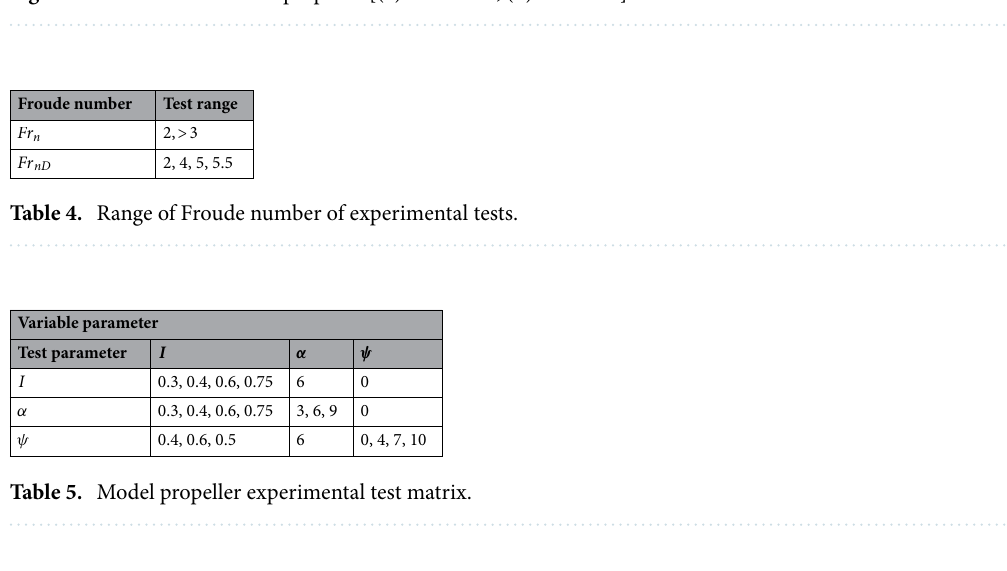
Figure 7. Constructed model propeller [( a ) front view, ( b ) side view].